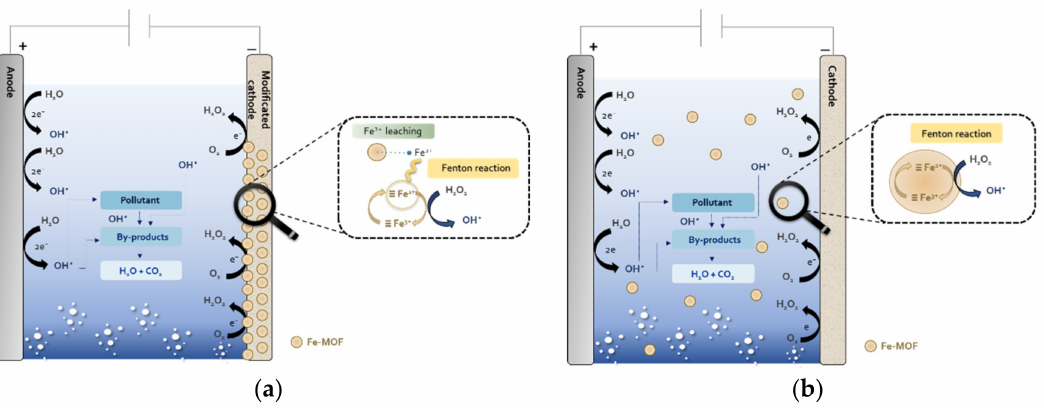
Figure 10. General scheme of the degradation electro-Fenton processes using ( a ) modified cathode with Fe-MOF and ( b ) Fe-MOF in bulk